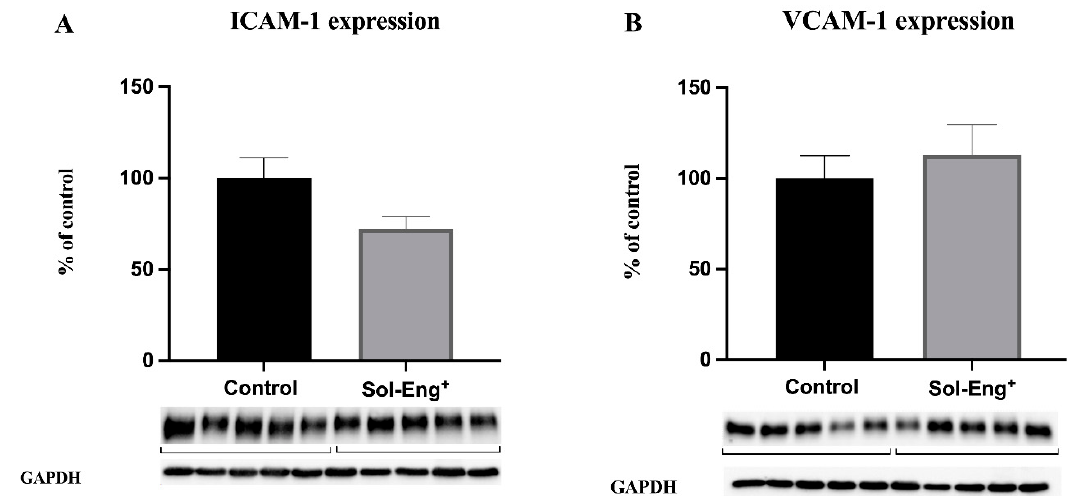
Figure 3. Expression of endothelial adhesion molecules in aortas of twelve-month-old male Sol-Eng + and control mice. Expression of ICAM-1 ( A ) and VCAM-1 ( B ) in total protein extract from mice aortas. Densitometric quantification of immunoreactive bands (top panel: densitometric analysis, control = 100%) was recalculated to the GAPDH signal (bottom panel: representative immunoblots). Data are shown as a mean ± S.E.M, Mann–Whitney test. n = 5 mice per group.